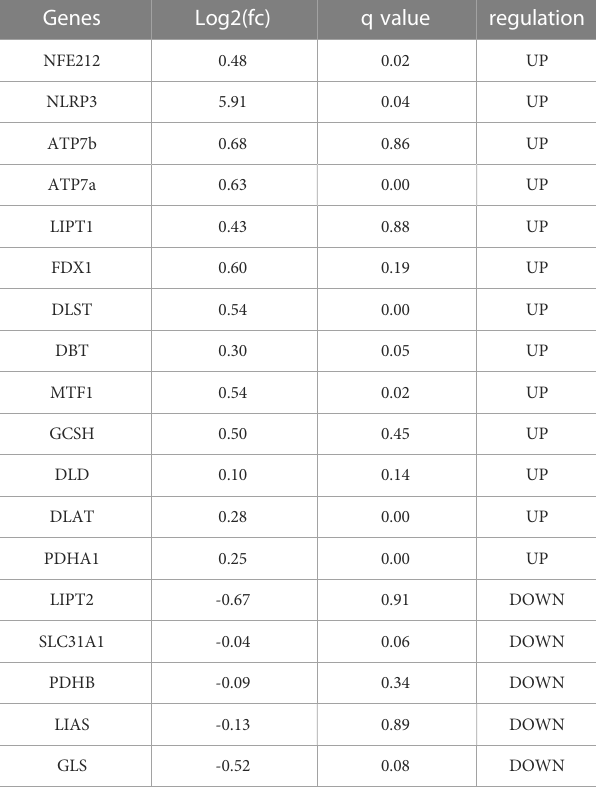
TABLE 2 The expression of cuprotosis related genes in abdominal aortic aneurysm specimen.